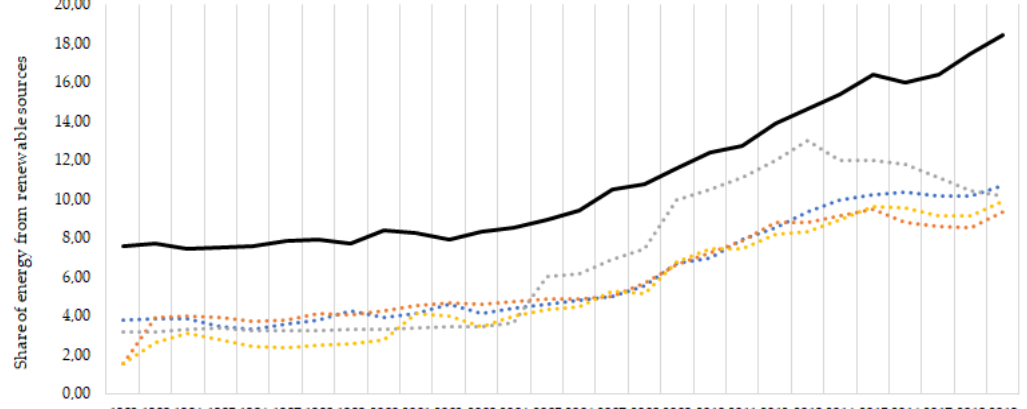
Figure 1. A plot of share of energy from renewable sources (RES) in V4 and in the EU countries before 2004 (EU-15) in 1992 – 2019.